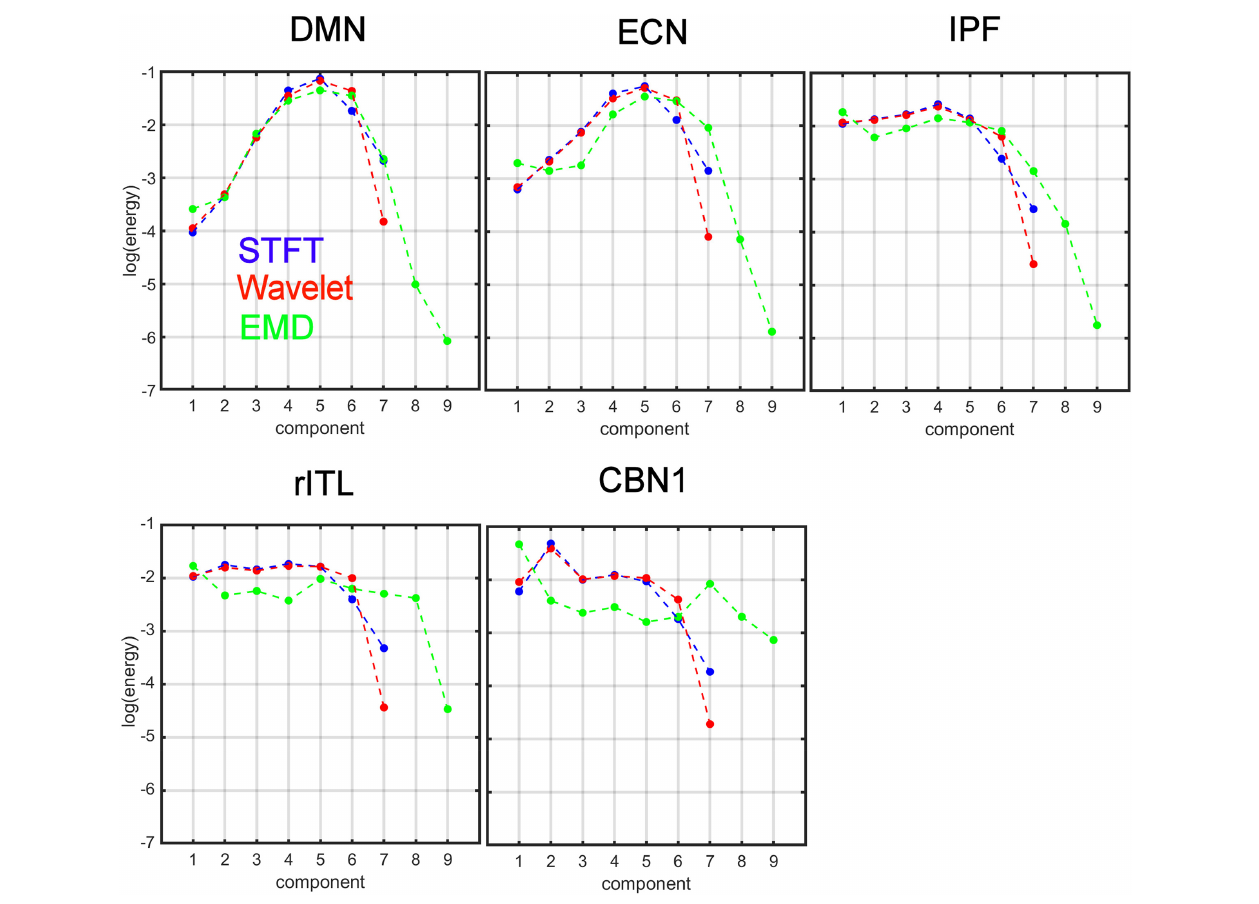
FIGURE 6 | Comparison of energy profiles averaged over all subjects using Short-Time Fourier Transform (STFT), Maximal Overlap Discrete Wavelet Transform (MODWT), and Empirical Mode Decomposition (EMD) for the different resting-state networks from Figure 5 . Note that these 5 networks were chosen to be representative networks of the clusters 1 to 5 in Figure 10